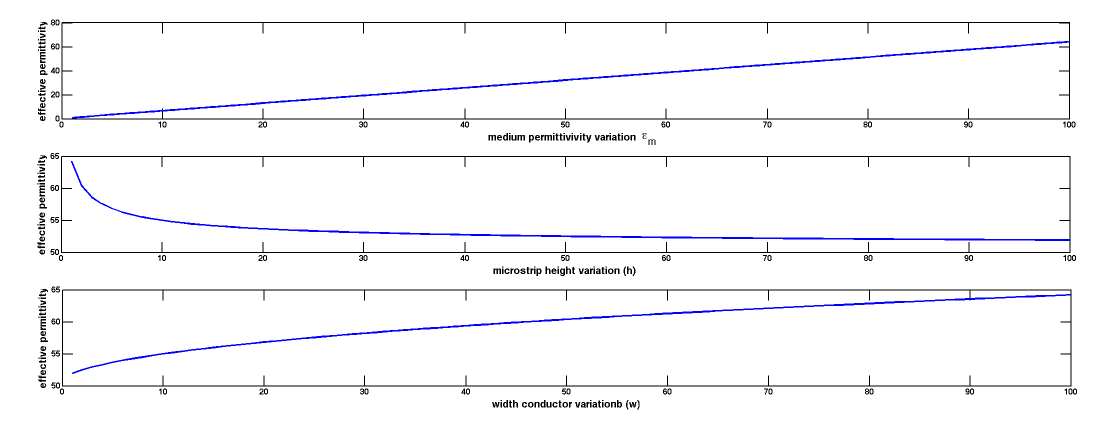
Figure 9. Microstip sensor proposed. Differential measures on electrodes are performed.